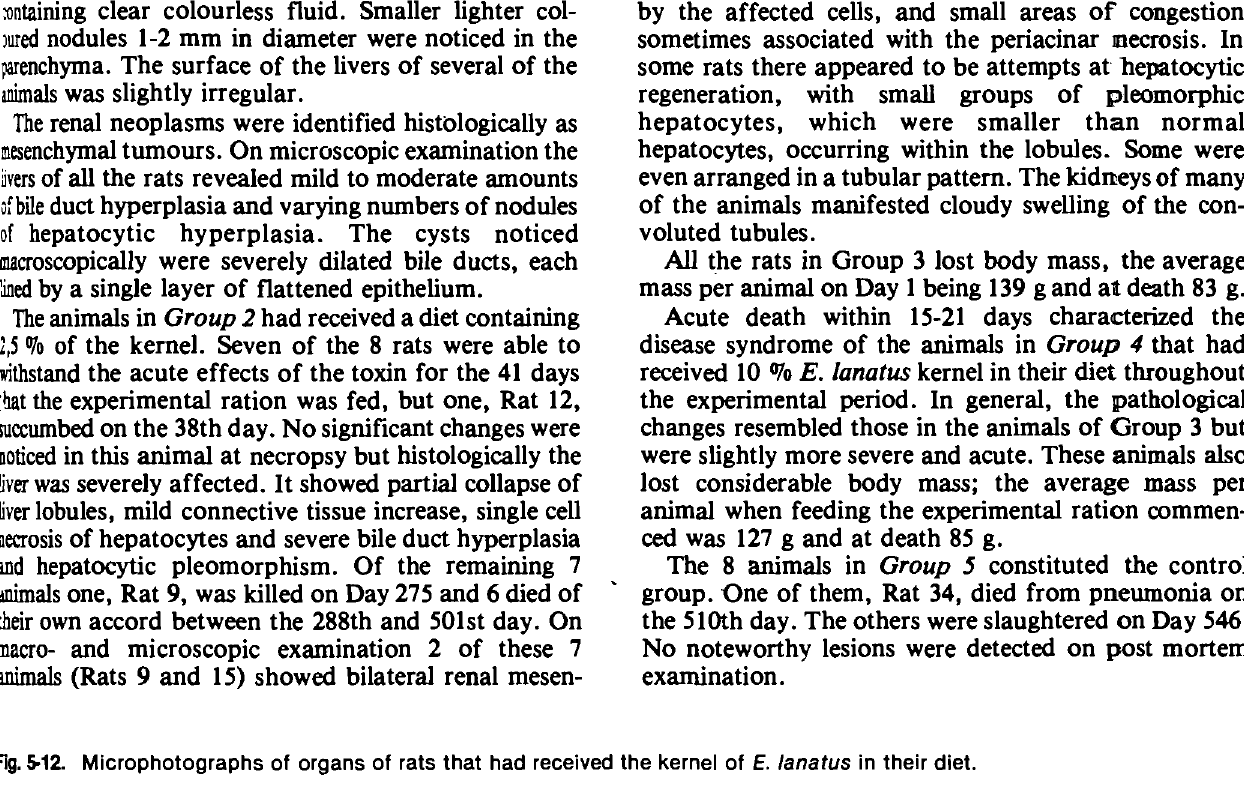
Fig. 9. Bile duct hyperplasia in liver of Rat 14. HE X120 FIg.10, Cystic bile duct hyperplasia in liver of Rat 10. HE X75 I Flg.11. One nodule of hepatocellular hyperplasia abutting on another. Rat 10. HE X300 Fig. 12. Pleomorphic neoplastiC cells in the hepatocellular carcinoma of Rat 14. HE X480 TYDSKRIF VAN DIE SUID-AFRlKAANSE VETERIN£RE VERENIGING-MAART